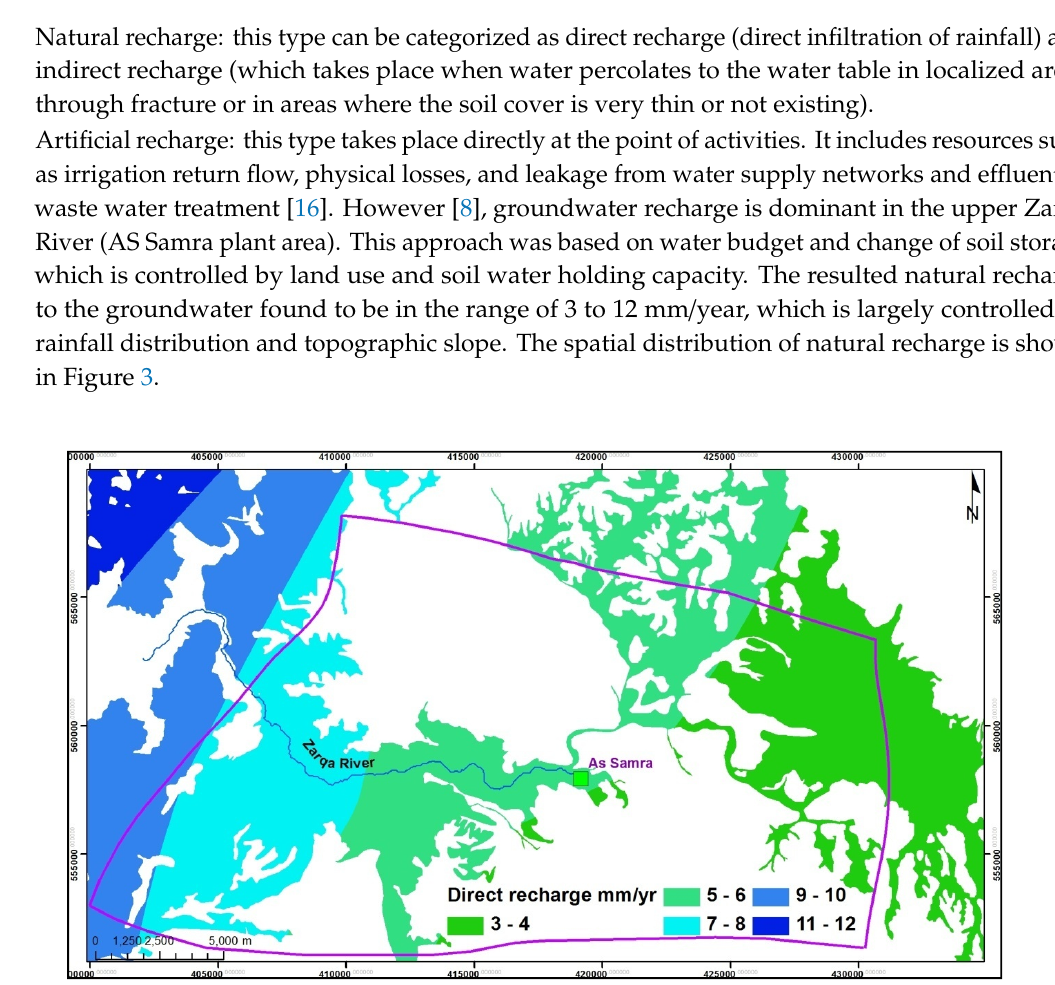
Figure 2. Cross section of Zarqa River.